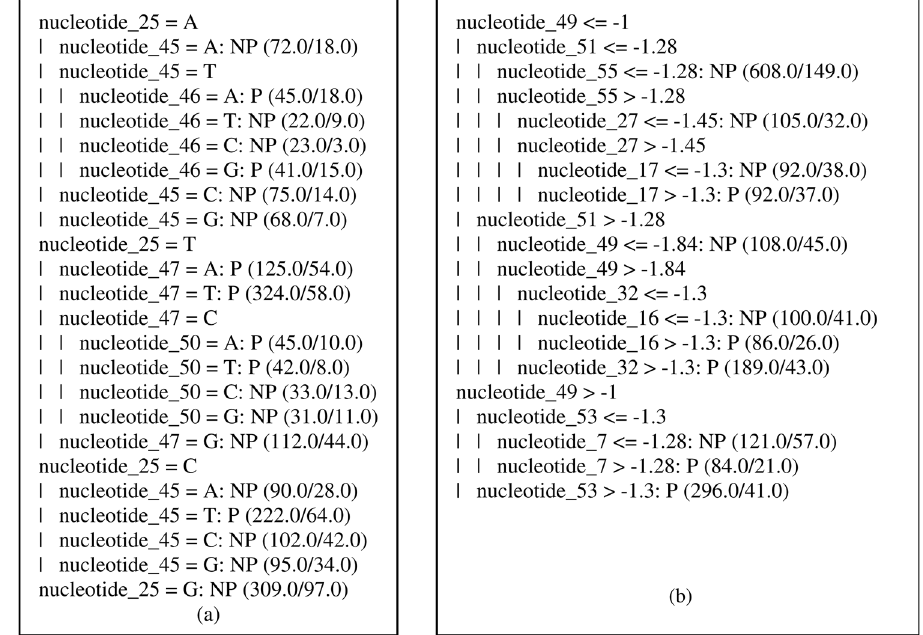
Figure 7 - Decision tree based on the J-48 algorithm. (a) Decision tree for the sequence-based simulation data. (b) Decision tree for the stability-based simulation data.